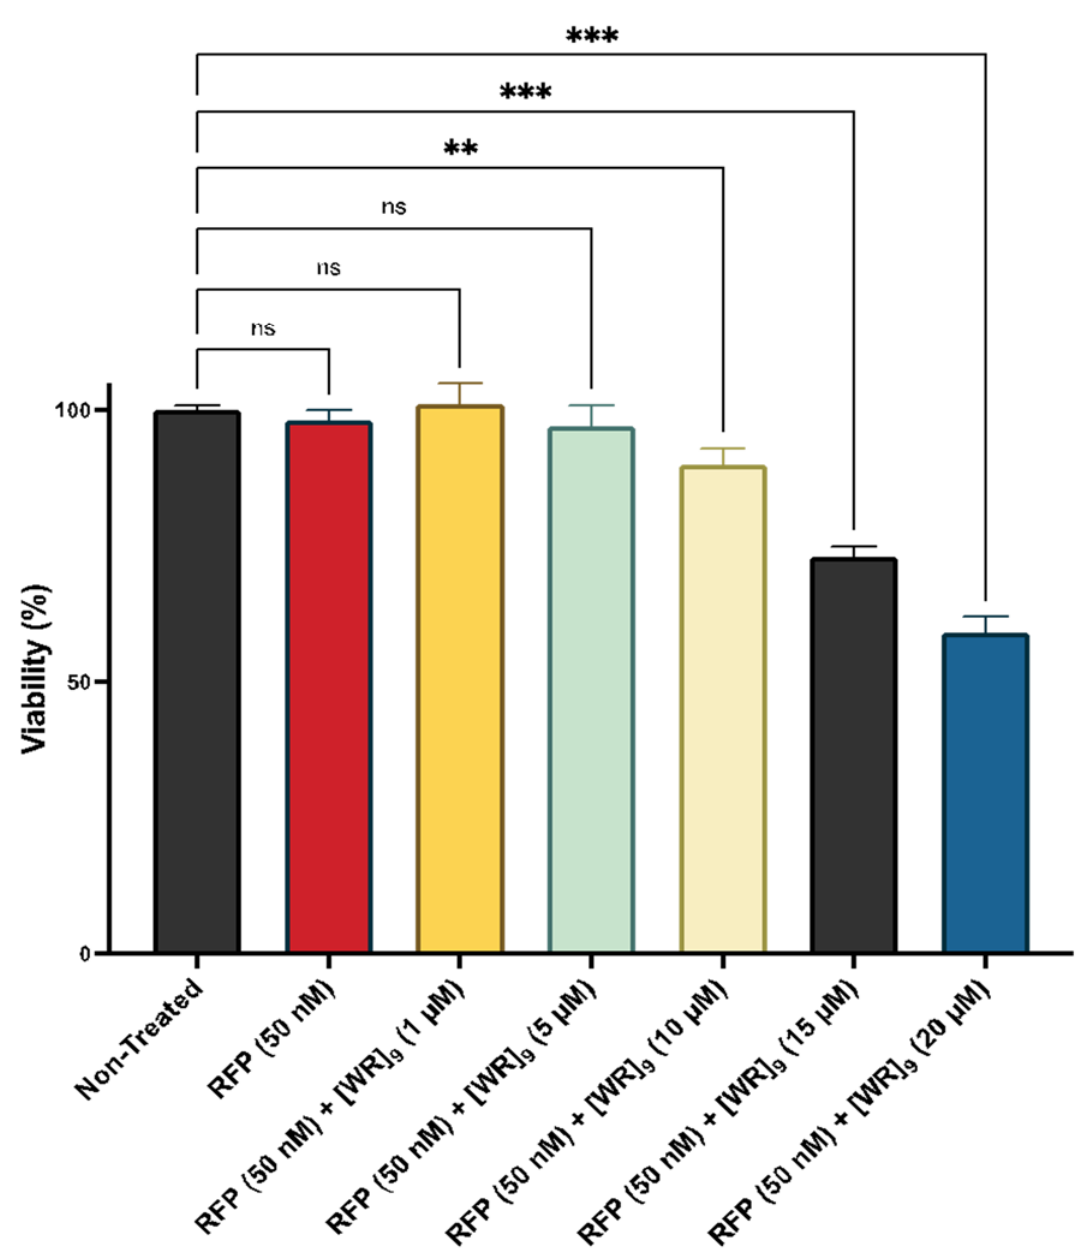
Figure 3. Cytotoxicity of [WR] 9 with RFP (50 nM) physical mixtures at different peptide concentra- tions (1–20 μ M) in breast cancer (MDA-MB-231) cell line after 24 h. The results are mean ± SD ( n = 3) (ns; no significance, ** p < 0.01, *** p < 0.001 treatments vs. Ctrl